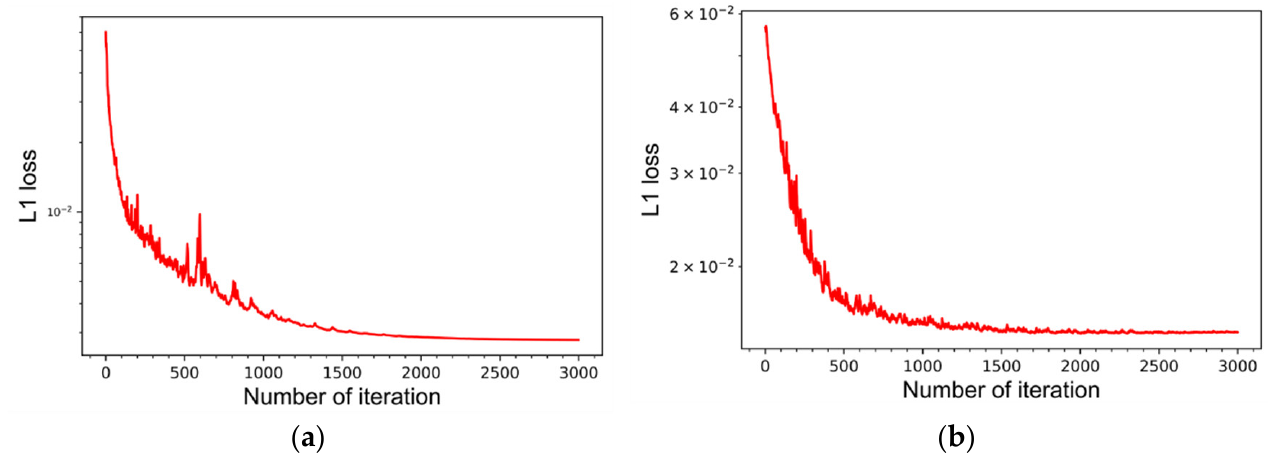
Figure 9. The variation of loss value during training ( a ) and validating ( b ) with epochs.